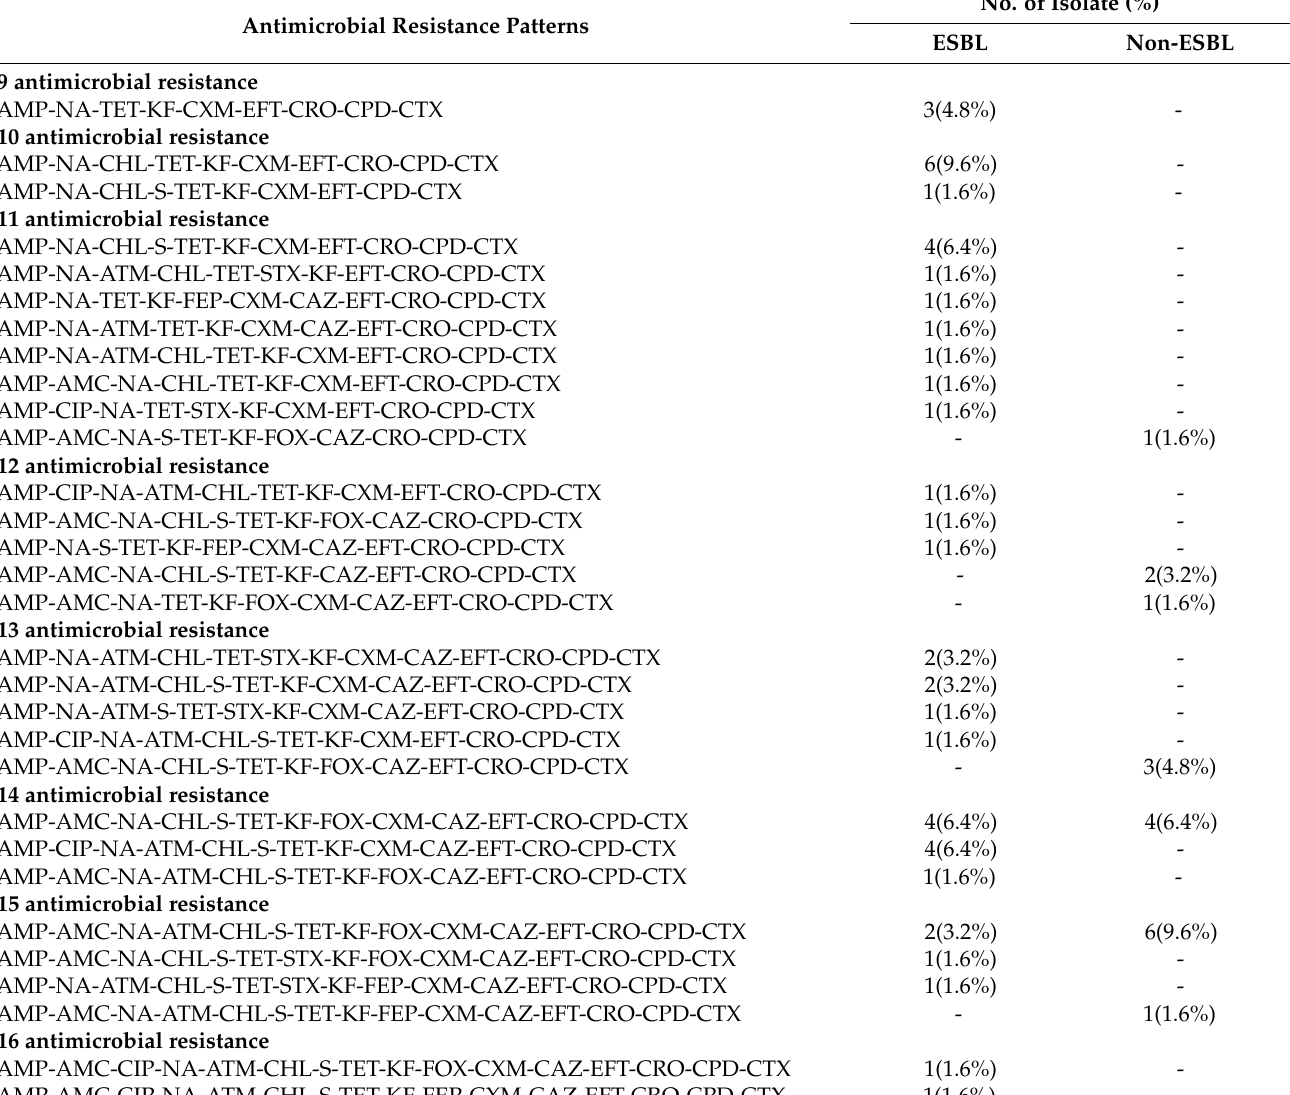
Table 2. Antimicrobial resistance patterns of ESBL and non-ESBL producing Salmonella Choleraesuis isolates from clinical